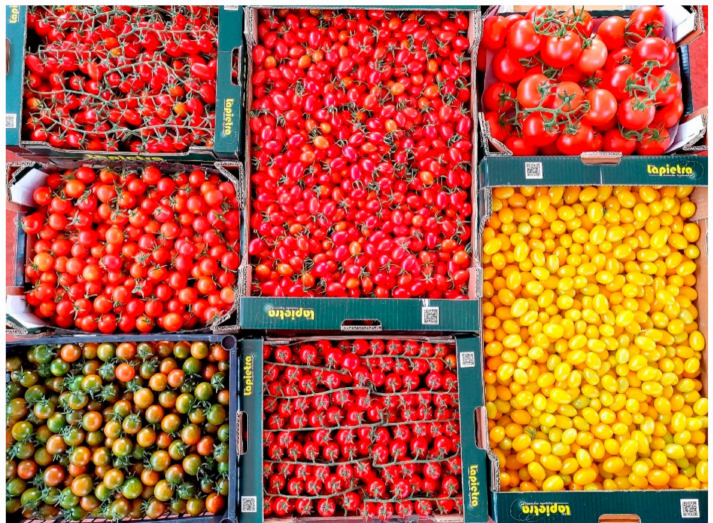
Figure 4. Example of tomatoes with high quality standards in soilless produced by “Lapietra” company [51,52]. Picture published under permission by F.lli Lapietra